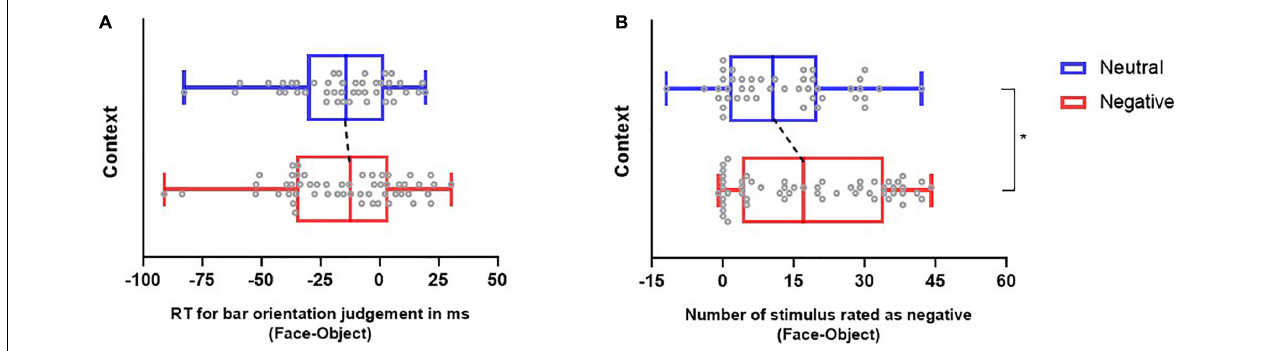
FIGURE 2 | The impact of context on emotional judgment and bar judgment tasks. Reaction time in the bar judgment task. (A) Values represent the bar judgment index (face-object RT) per context. (B) Quantification of stimulus judged as negative. Values represent the emotional judgment index (face-object) per context. Note that we found an increase in neutral faces judged as negative in the negative context in comparison to the neutral context. Boxplots present the median, the interquartile range and the minimum and maximum values. The circles represent the data for each subject per condition, the black dashed line marks the shift between medians, and * P ≤